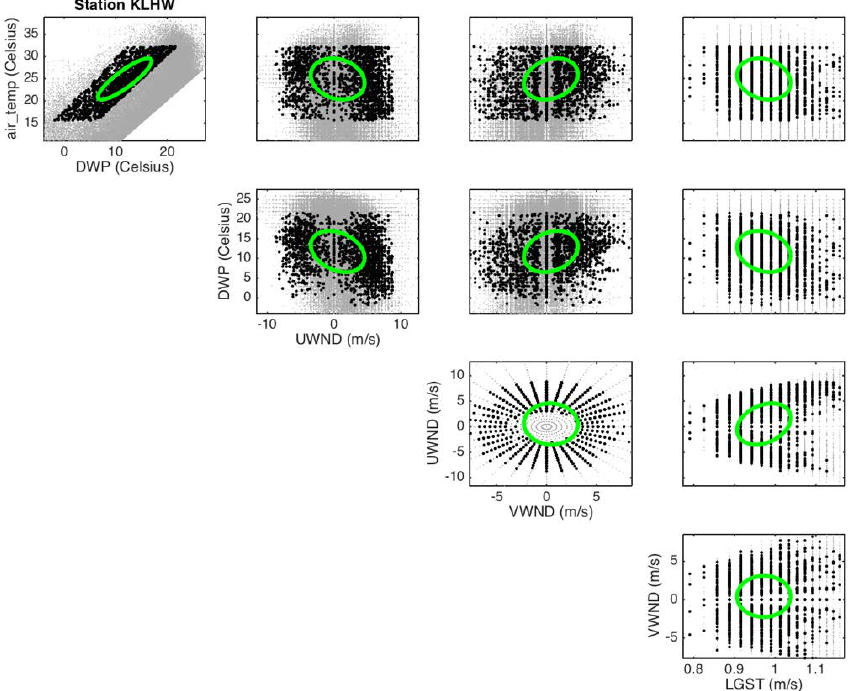
Figure A7. As in Figure 4 but for station